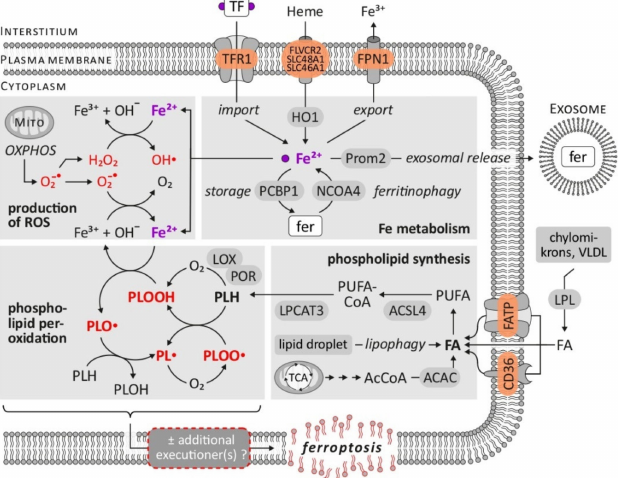
Figure 2. Ferroptosis—biochemical hallmarks and prerequisites. The figure summarizes the central biochemical characteristics of ferroptosis, i.e., generation of ROS, aspects of cellular iron metabolism, synthesis of phospholipids as targets of lipid peroxidation, as well as lipid perox- idation itself. While the latter represents the defining hallmark of ferroptosis, possible down- stream mechanisms (executioner(s)) causing the final ferroptotic phenotype remain elusive. Ab- breviations: ACAC = acetyl-CoA carboxylase, AcCoA = acetyl-coenzyme A, ACSL4 = acyl-CoA synthetase long-chain family member 4, FA = fatty acid, FATP = fatty acid transport protein, fer = ferritin, FLVCR2 = feline leukemia virus subgroup C cellular receptor 2, FPN1 = ferroportin 1, HO1 = heme oxygenase 1, LOX = lipoxygenase, LPCAT3 = lysophosphatidylcholine acyltrans- ferase 3, LPL = lipoprotein lipase, MITO = mitochondrion, NCOA4 = nuclear receptor coactivator 4, OXPHOS = oxidative phosphorylation, PCBP1 = poly-(rC)-binding protein 1, PL · = phospho- lipid radical, PLH = phospholipid, PLO · = alkoxyl phospholipid radical, PLOO · = peroxyl